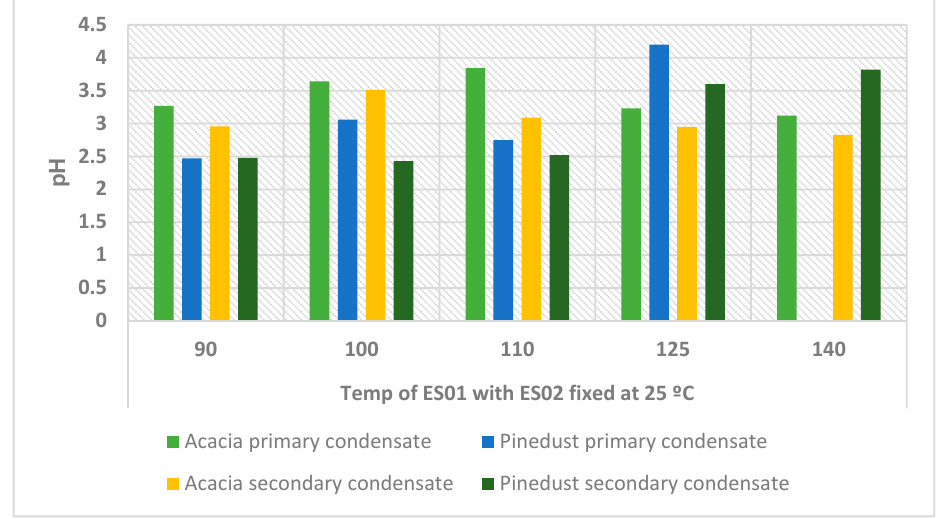
Figure 4. pH of various bio ‐ oil fractions at different primary condenser temperatures for a sample .